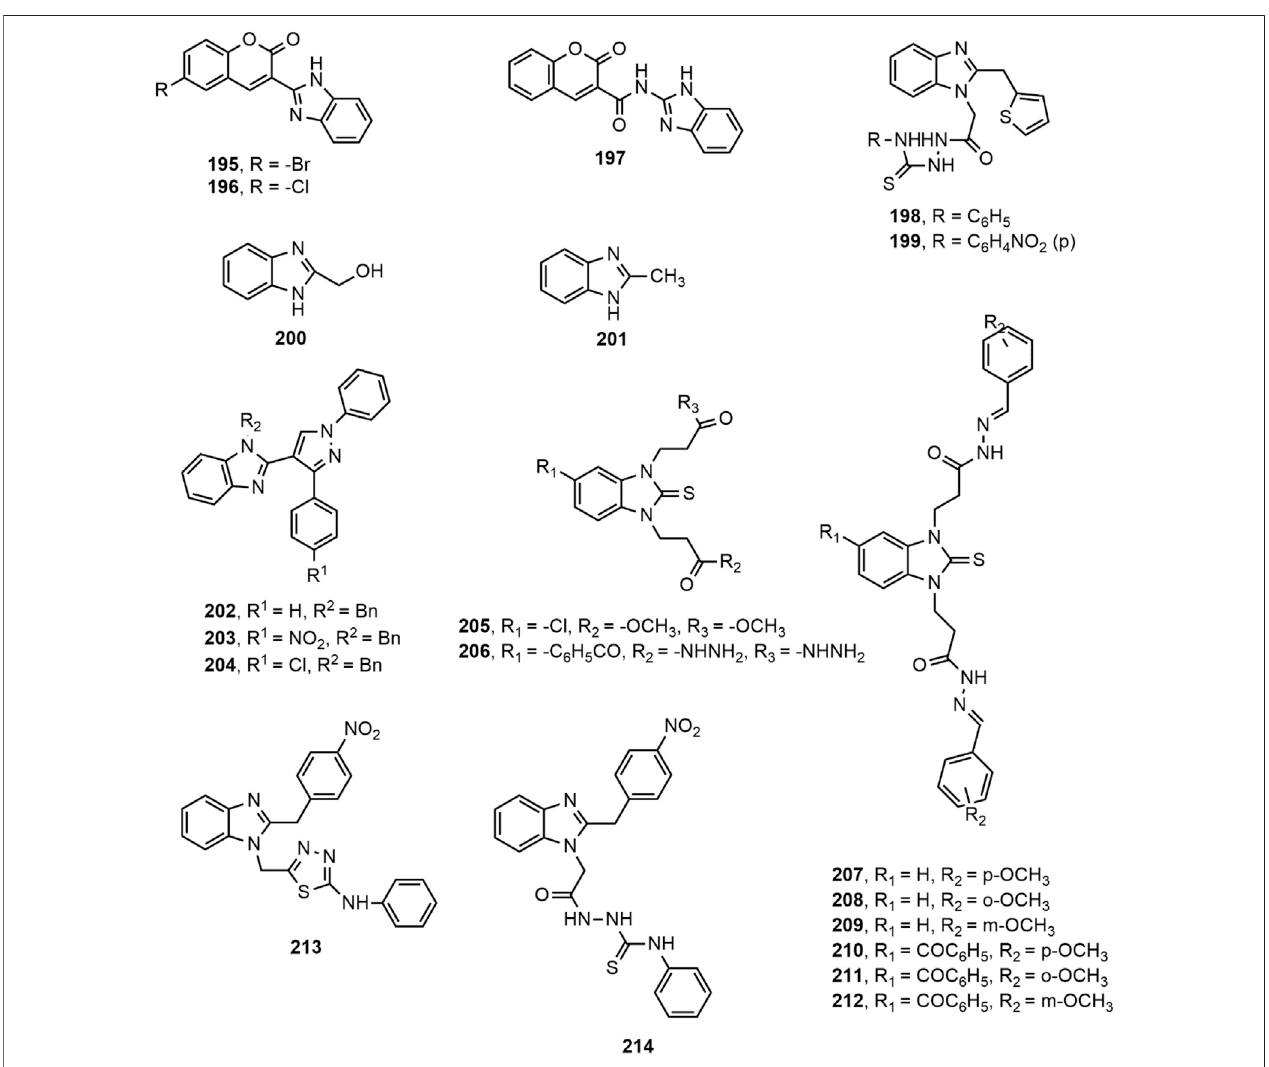
FIGURE 8 | Benzimidazole derivatives with antioxidant